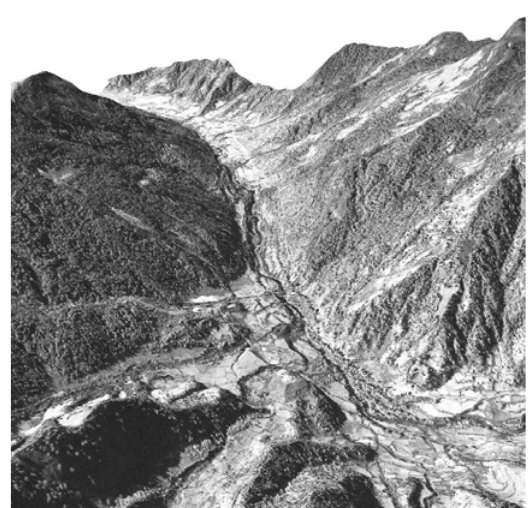
Figure 3: Map showing the hilltop complex and the lower building remains at the foot of the hill. The ruins were photogrammetrically mapped from UAV images, the Digital Surface Model and the contour lines were generated from GeoEye-1 satellite imagery using the software